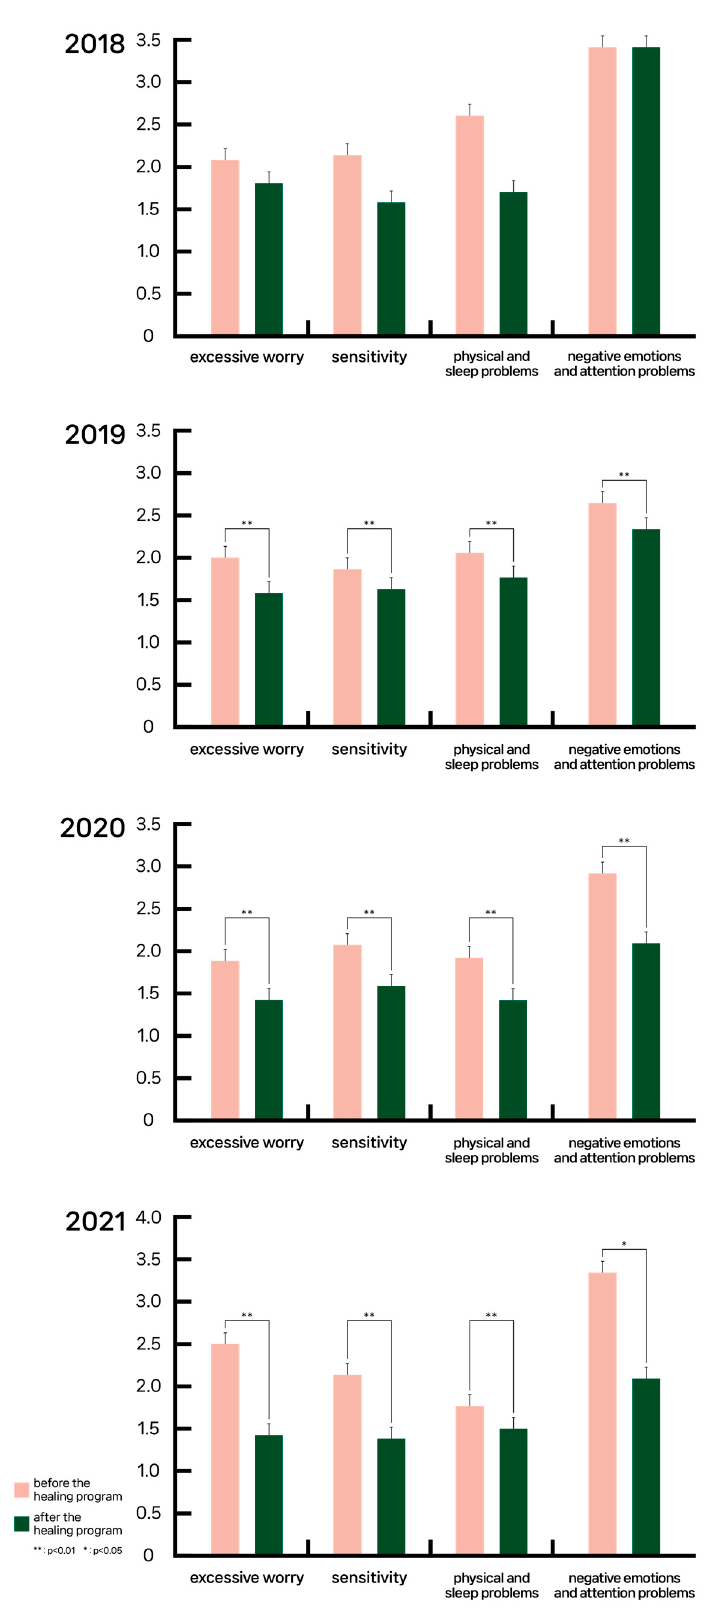
Figure 2. Results of RCMAS subdomains for each year 2018–2021.